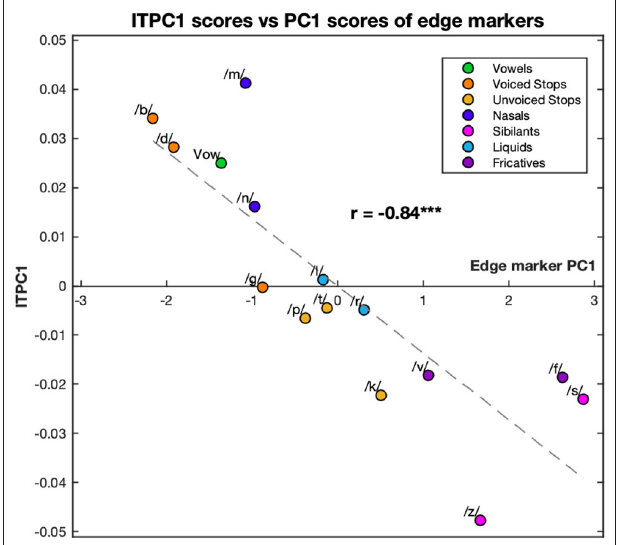
FIGURE 5 | Correlation between the first principal component of the ITPC and edge markers. The values of ITPC1, corresponding to the EEG response, are plotted against the PC1 scores corresponding to different edge markers of the syllables. Both ITPC1 and PC1 values are averaged over phonemic condition. Each color corresponds to a different condition (see legend). Dashed line represents the line of best fit (least means squares). The correlation coefficient is given above this line. *** p <